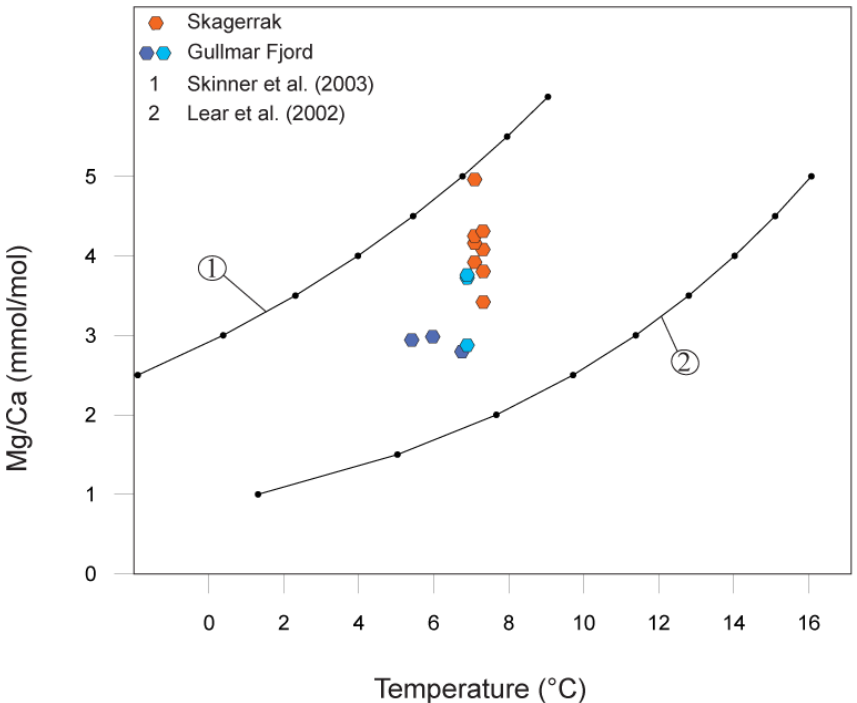
Fig. 3b. Mg/Ca vs. temperature for G. turgida from this study from the Skagerrak (hexagons: orange) and the Gullmar Fjord (hexagons: dark blue represents stained, and light-blue non-stained samples) in comparison with the calibrations for G. affinis (Skinner et al., 2003; “1”), and for multiple species (Lear et al., 2002; “2”). Note that the points in the two calibrations do not represent samples. Error bars are too small to be displayed (see Methods